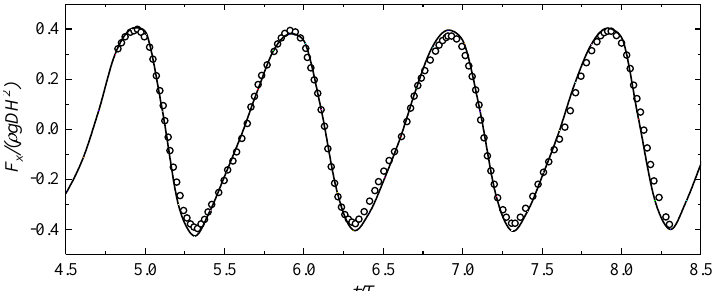
Figure 6. Time history of the dimensionless force acting on the pile. Circles: the experimental data; Solid line: numerical